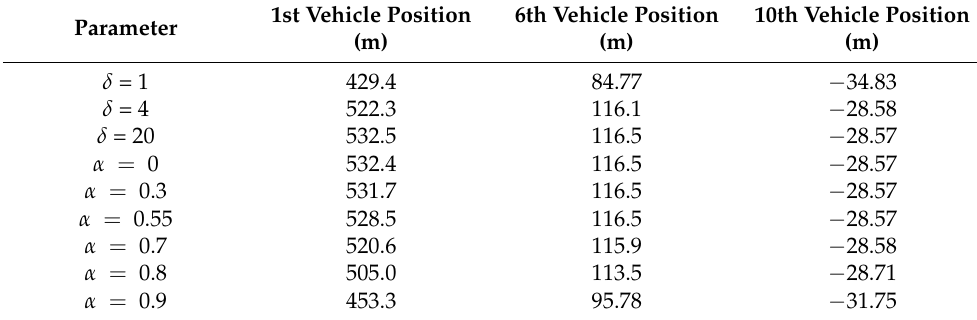
Table 6. Positions of the 1 st, 6 th, and 10 th vehicles at 40 s with the ID and proposed models. Parameter